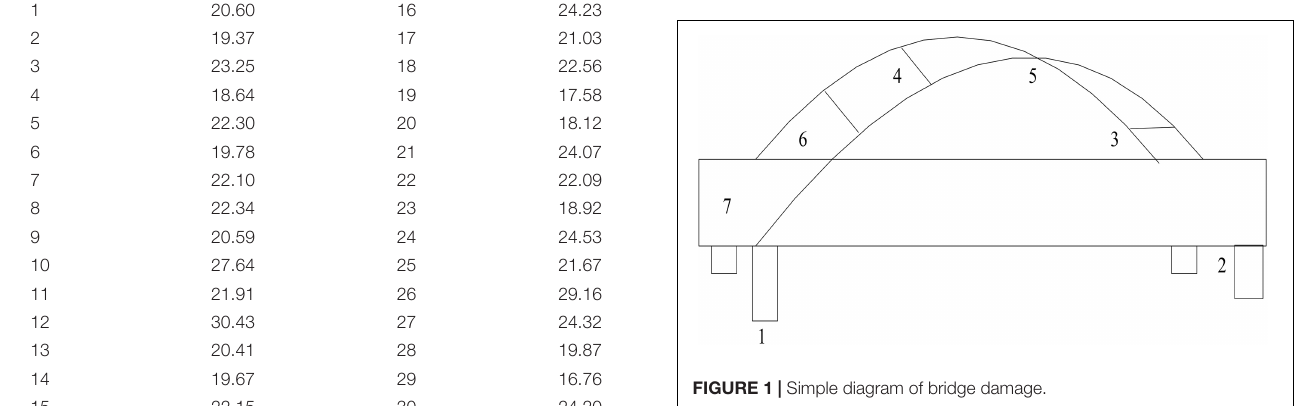
FIGURE 1 | Simple diagram of bridge